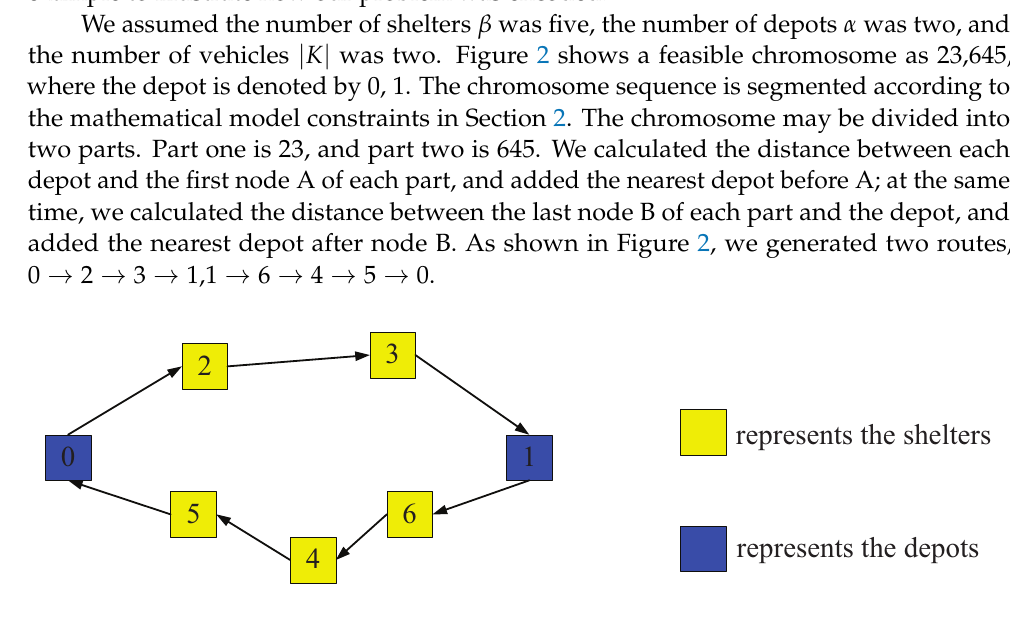
Figure 2. A reasonable chromosome encoded in